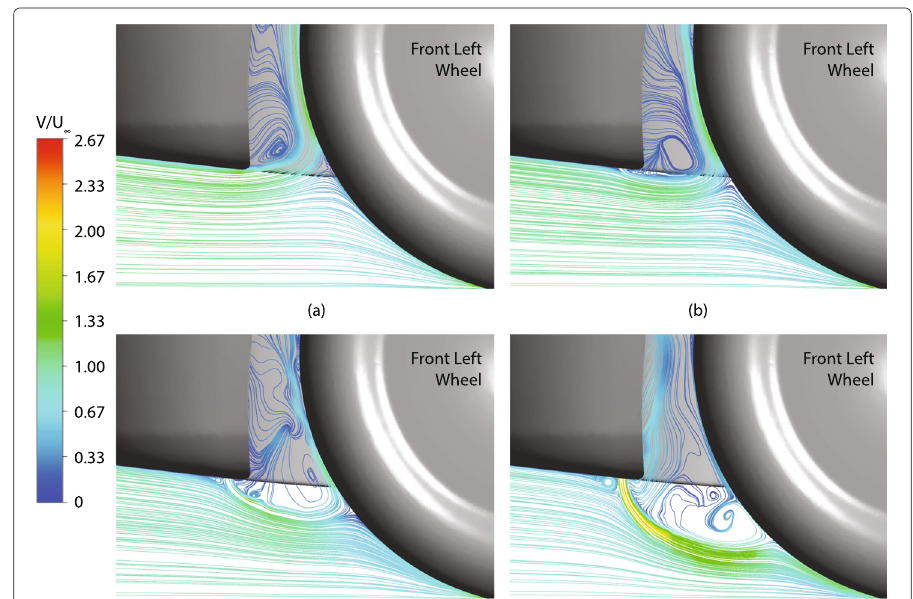
Fig. 16 Streamlines, colored by dimensionless velocity magnitude, approaching the front left wheel of the notchback DrivAer reference model for U ∞ = 15 m/s ( a ) baseline, ( b ) 90 ◦ air jet with U = 1/3, ( c ) 90 ◦ air jet with U = 3/3, and ( d ) 90 ◦ air jet with U =